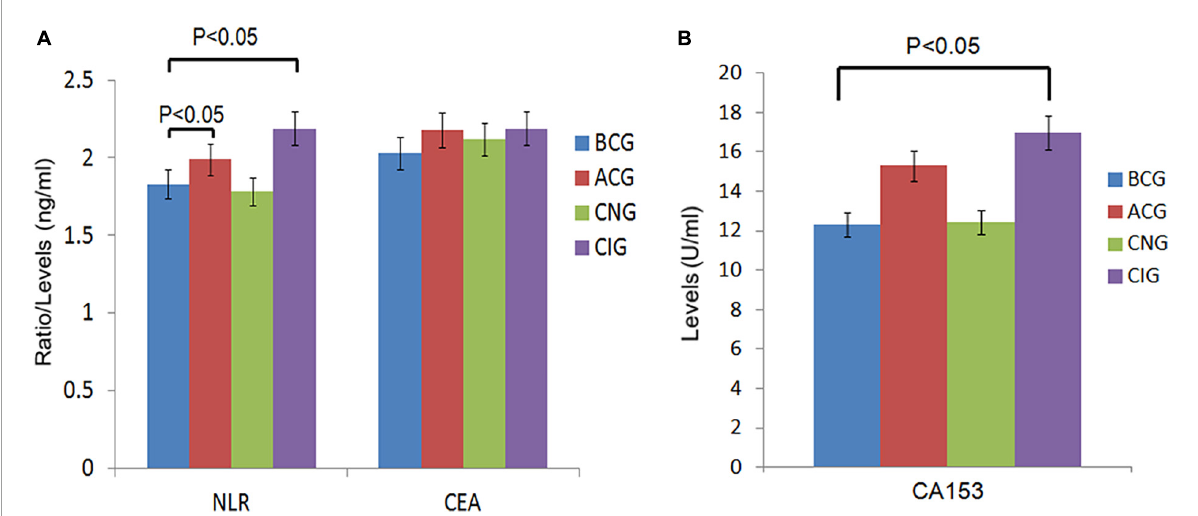
FIGURE1 Comparison of peripheral blood biomarkers levels between groups. (A) Comparison of NLR and CEA levels between the 4 groups, BCG and ACG, BCG and CNG, BCG and CIG, CNG and CIG, respectively. Significant differences in NLR levels were observed between the BCG ( n = 66) and ACG ( n = 121), BCG ( n = 66) and CIG ( n = 77), P < 0.05. There were no significant differences in NLR levels between the BCG ( n = 66) and CNG ( n = 44), CNG ( n = 44) and CIG ( n = 77), and CEA levels, P > 0.05. (B) Comparison of CA153 levels between the 4 groups, BCG and ACG, BCG and CNG, BCG and CIG, CNG and CIG, respectively. Significant differences in CA153 levels were observed between the BCG ( n = 66) and CIG ( n = 77), P < 0.05. There were no significant differences in CA153 levels between other groups, P >